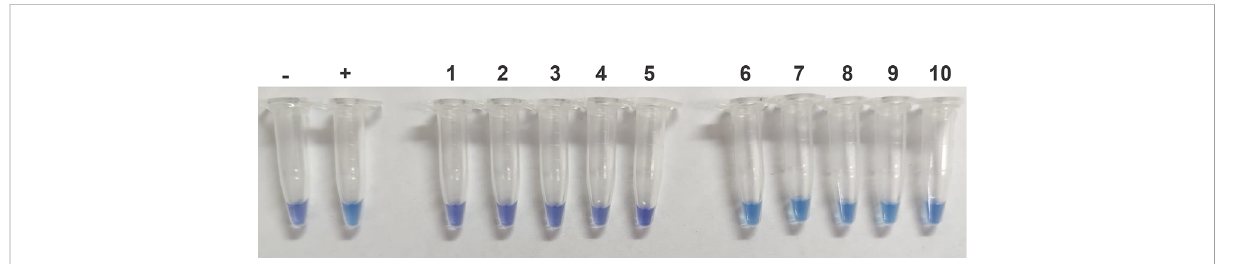
FIGURE 3 Performance of hydroxynaphthol blue (HNB) – loop-mediated isothermal ampli fi cation (LAMP) to detect C .Las in samples without puri fi ed DNA. The samples were previously treated with NaOH solutions, heated for 10 min at 100°C, and neutralized with HCl solution. The extract was used as a template for the LAMP reaction. Negative control ( − ), positive control (+), 1 – 5 samples from uninfected plants, and 5 – 10 samples from plants infected with C